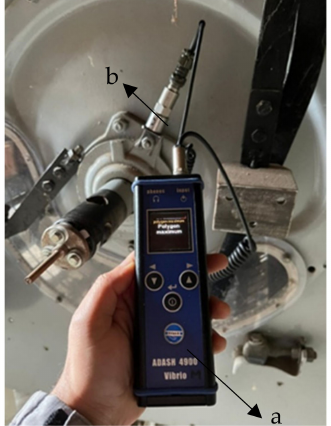
Figure 5. a. Adash A4900 Vibrio M device; and b. AC150 piezoelectric